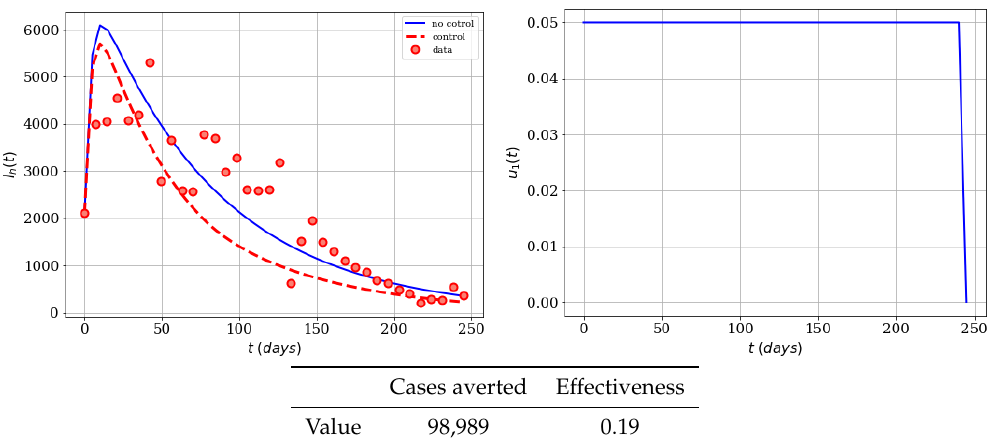
Figure 2. Numerical simulation of an educational campaign ( κ 1 = 0.1, u 1 max = 0.05) on the infected humans of the Zika mathematical model (1). Results regarding effectiveness are given in the table. The dots represent the real cases of infected people in Colombia for